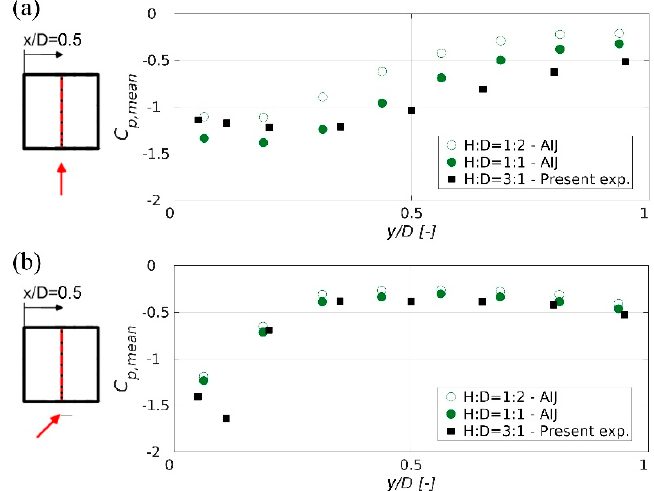
Figure 9. Mean distributions of the surface pressure coefficient ( C p,mean ) along alignment x/D = 0.5 for different building configurations, a half cube H/D = 1:2 and a cube H/D = 1:1 from the Architectural Institute of Japan (AIJ) database and high-rise H/D = 3:1 from the present experiment for two wind angles: ( a ) 0° and ( b ) 45°.